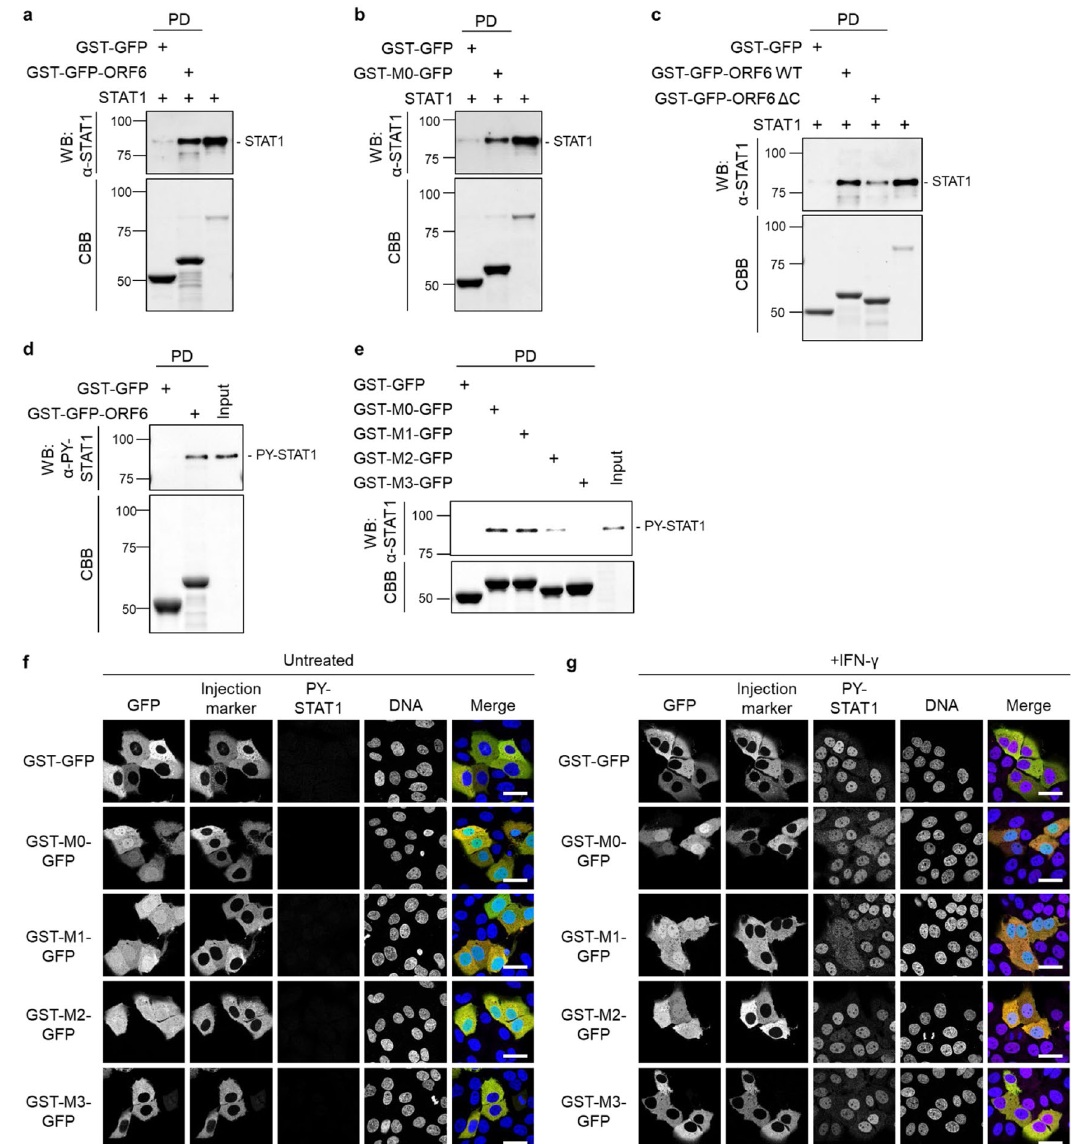
Fig. 4 The C-terminal sequence of ORF6 disrupts the nuclear localization of STAT1. a The bacterially puri fi ed STAT1 recombinant protein was incubated with either GST-GFP or GST-GFP-ORF6 immobilized on glutathione Sepharose beads (GST-beads) for 1 h, and the pulled-down protein was collected (indicated as PD). STAT1 was detected with anti-STAT1 antibody (WB). The bottom panel represents the proteins bound to the GST-beads and stained with Coomassie Brilliant Blue (CBB). The right lane was loaded with the STAT1 protein (1/15,000 dilution of the reaction) as an input protein. Values are kDa. b The STAT1 recombinant protein was incubated with either GST-GFP or GST-GFP fused with the C-terminal peptide of ORF6 wild type (49-61 amino acids; GST-M0-GFP) immobilized on GST-beads for 1 h, and then a pulled-down protein was collected (PD). STAT1 was detected using anti-STAT1 antibody (WB). The bottom panel represents the proteins bound to the beads and stained with CBB. The right lane loaded with the STAT1 protein (1/ 10,000 dilution of the reaction) as an input protein. Values are kDa. c The STAT1 recombinant protein was incubated with either GST-GFP, GST-GFP-ORF6 wild type (WT), ore GST-GFP-ORF6 C-terminal deletion mutant lacking a.a. 49 – 61 ( Δ C) immobilized on GST-beads for 1 h, and then a pulled-down protein was collected (PD). STAT1 was detected using anti-STAT1 antibody (WB). The bottom panel represents the proteins bound to the beads and stained with CBB. The right lane loaded with the STAT1 protein (1/15,000 dilution of the reaction) as an input protein. Values are kDa. d Lysates from HeLa cells stimulated with IFN- γ were incubated with either GST-GFP or GST-GFP-ORF6 immobilized on GST-beads for 1 h, and the pulled-down proteins were collected (PD). PY-STAT1 was detected with a speci fi c antibody (WB). The bottom panel represents the proteins bound to the beads and stained with CBB. The input was a 1/500 dilution of cell lysates used for the reaction. Values are kDa. e Lysates from HeLa cells stimulated with IFN- γ were incubated with GST-GFP, GST-M0-GFP, GST-M1-GFP, GST-M2-GFP, or GST-M3-GFP, which were immobilized on GST-beads for 1 h, and the pulled-down proteins were collected (PD). PY-STAT1 was detected with a speci fi c antibody (WB). The bottom panel represents the proteins bound to the beads and stained with CBB. The input was a 1/1,000 dilution of cell lysates used for the reaction. f , g Huh7 cells were microinjected with either GST-GFP, GST-M0-GFP, GST-M1-GFP, GST-M2-GFP, or GST-M3-GFP proteins (green), as well as a Fluorescence-conjugated antibody (red) as an injection marker, into the cytoplasm. The injected cells were incubated f or treated without IFN- γ g for 30 min, and PY-STAT1 (magenta) was detected using speci fi c antibodies. DAPI was used for DNA staining (blue). Scale bars: 30 μ